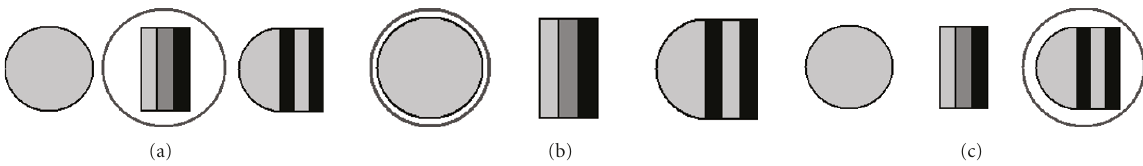
Figure 5: (a) First maximal complexity region for gray-level entropy, (b) orientations entropy, (c) and combined